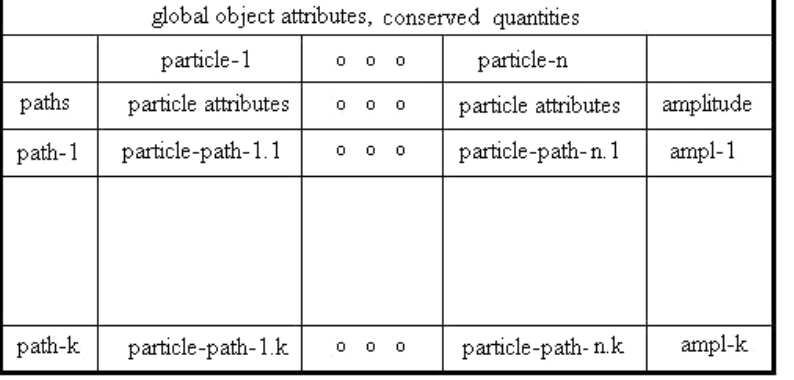
Fig. 7. Structure of the quantum object consisting of two entangled